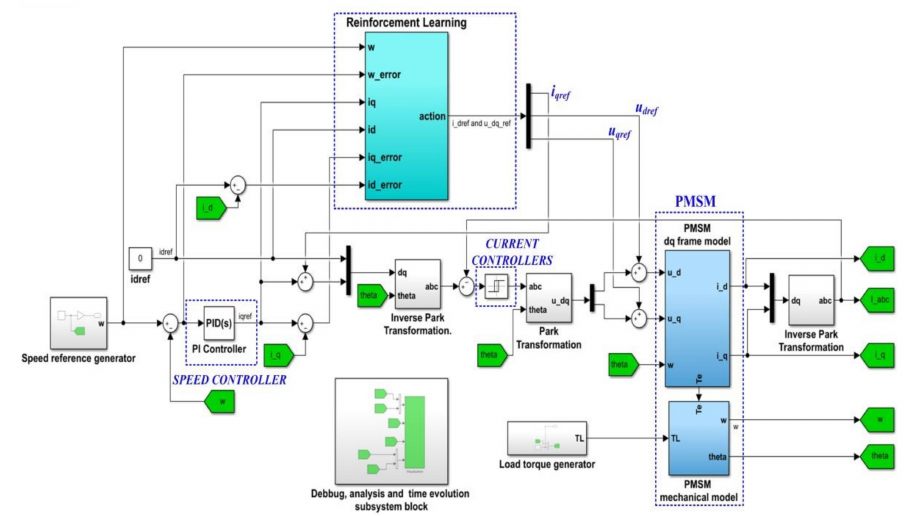
Figure 11. Block diagram of MATLAB/Simulink implementation for the PMSM control based on